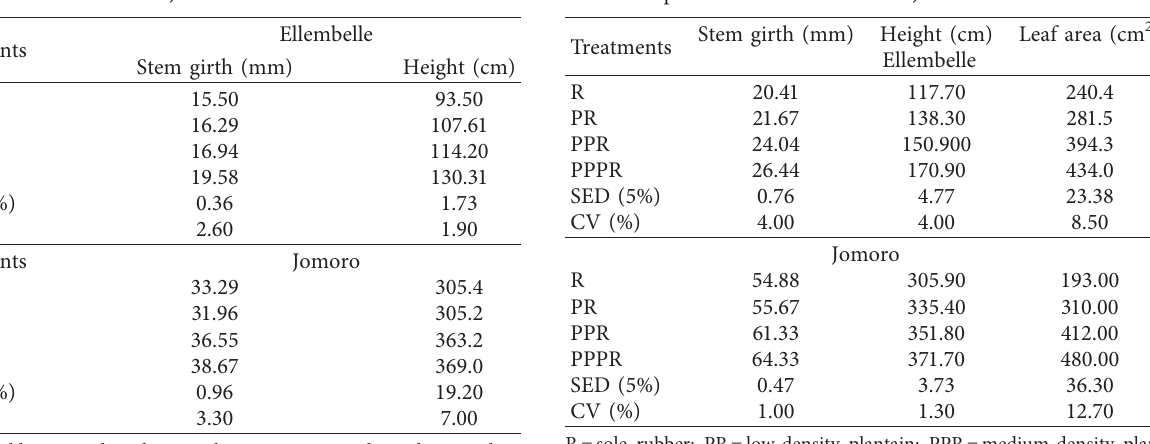
Figure 6: Correlation between girth and days after planting (DAP) of rubber in the rubber-plantain intercropping systems at Jomoro study site, Western region, Ghana. R � sole rubber; PR � low-density plantain; PPR � medium-density plantain; PPPR � high-density plantain. Table 2: Stem girth and height growth of rubber tree at flowering of Table 3: Stem girth, height, and leaf area growth of rubber tree at plantain at Ellembelle and Jomoro. harvest of plantain at Ellembelle and